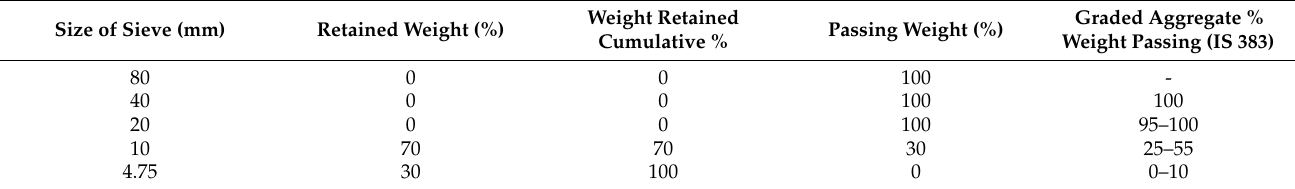
Table 4. Proportions of different size fractions of CA.